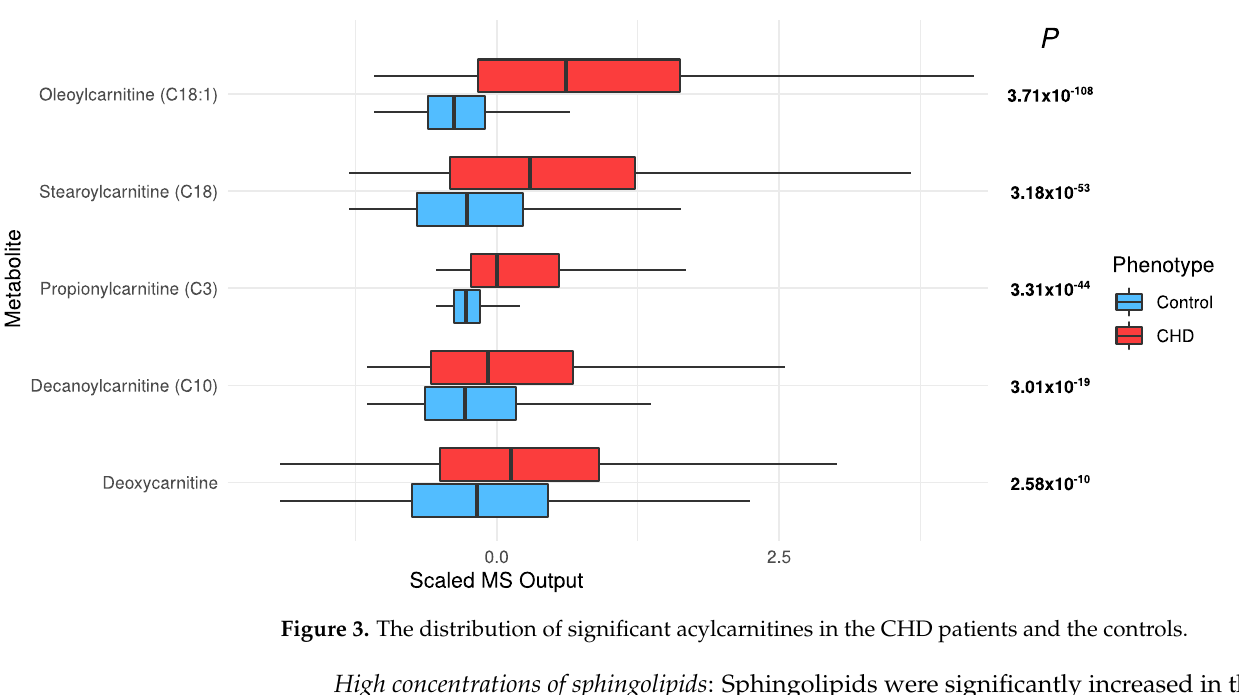
Figure 4. The distribution of long-chain chain fatty acids in the CHD patients and the controls.